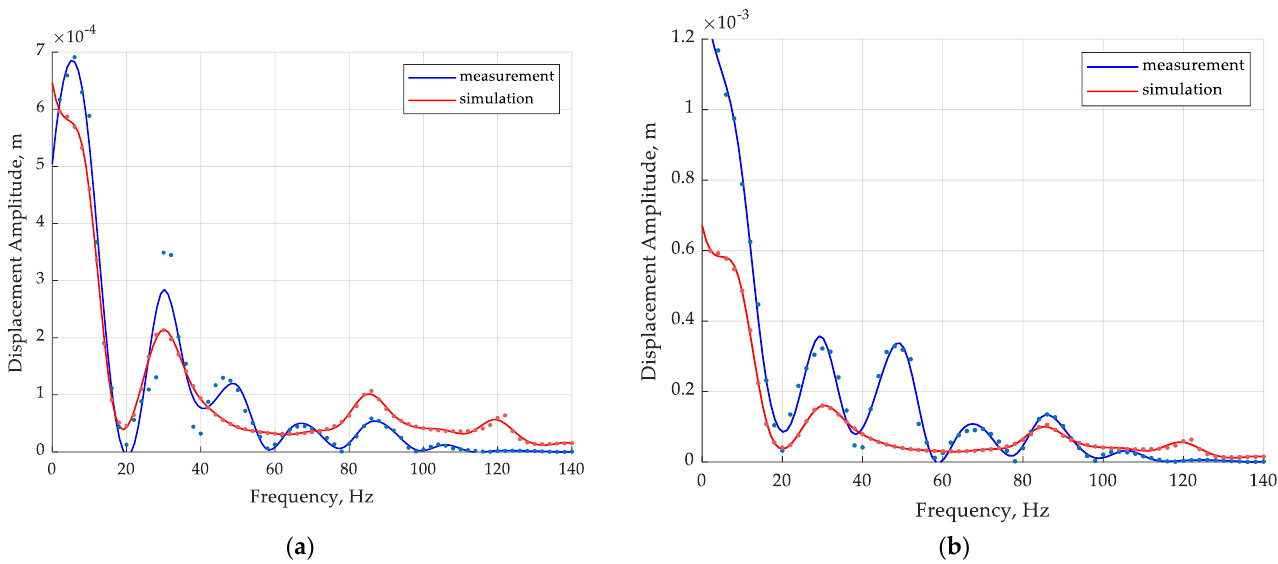
Figure 14. The amplitude as a function of the frequency of the measured and simulated levitated magnet movement for constant input current ( a ) 0.35 A and ( b ) 0.75 A.